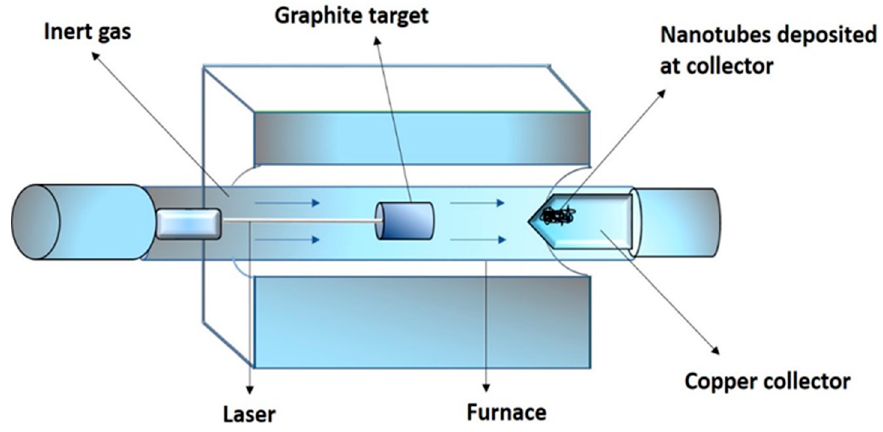
Figure 6. Schematic structure showing the laser ablation method.